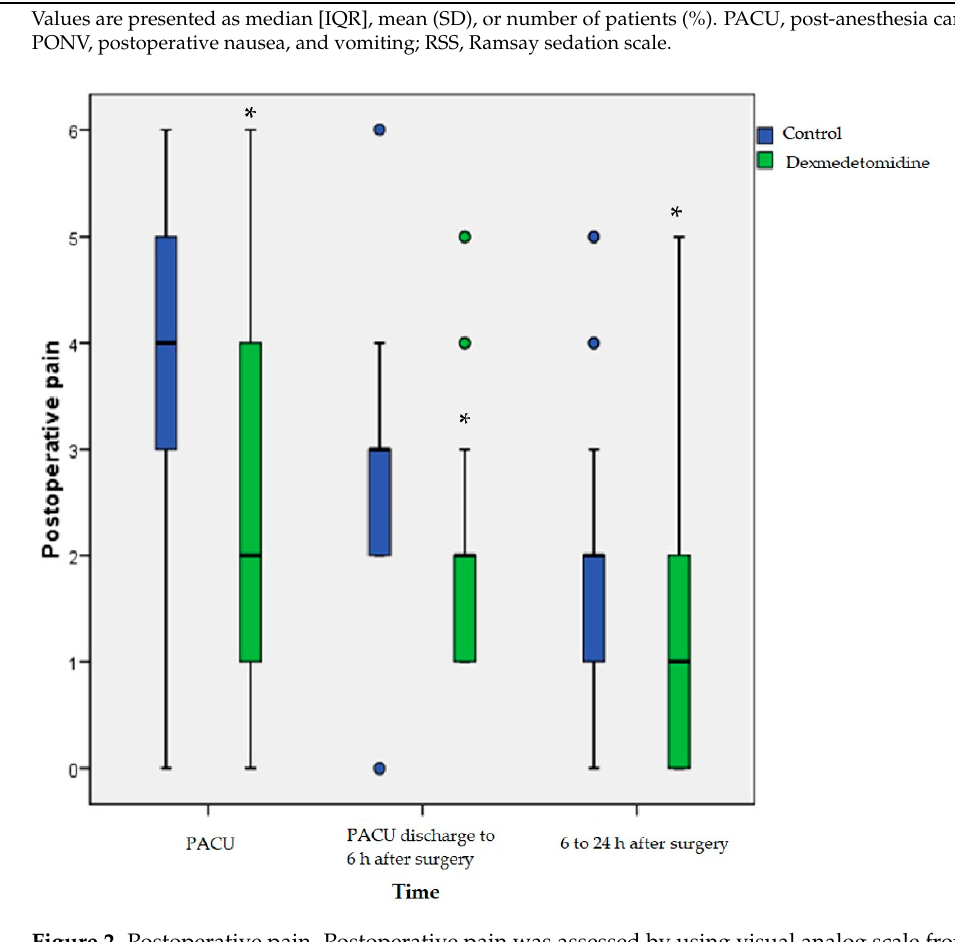
Figure 2. Postoperative pain. Postoperative pain was assessed by using visual analog scale from 0 to 10. The box plots represent the median, interquartile range, 10th and 90th percentile (whiskers), and outliers (points). PACU, post-anesthesia care unit. * p < 0.05 compared with two groups.